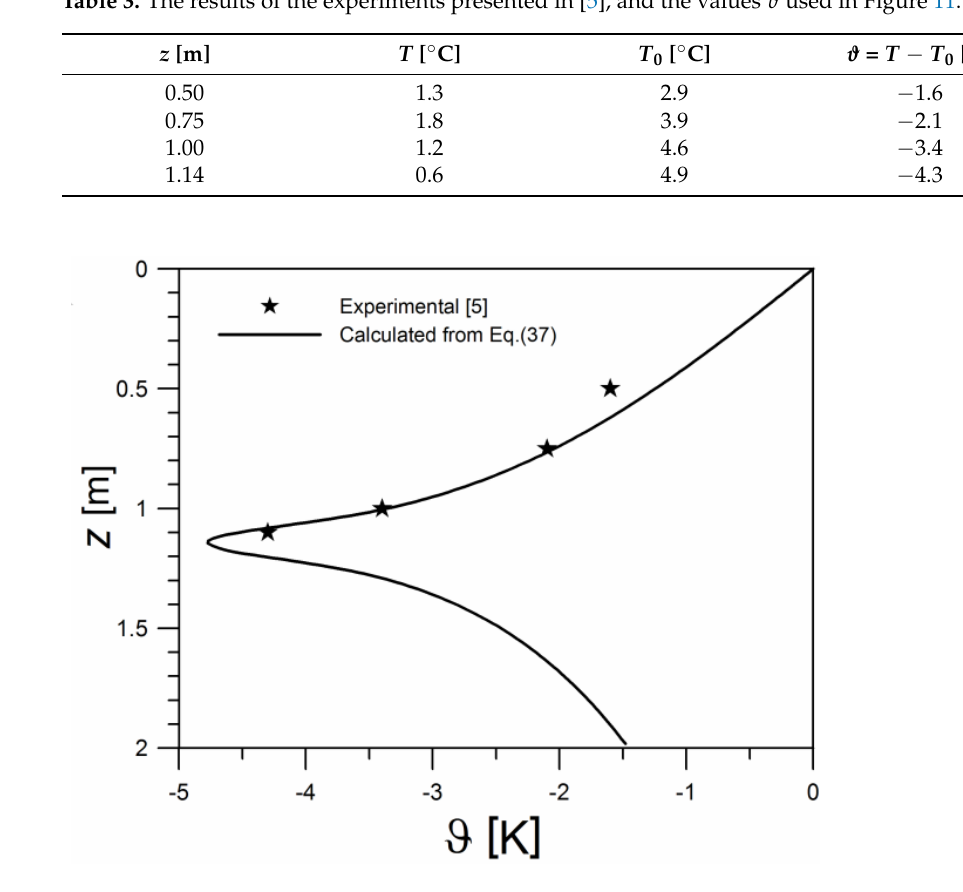
Figure 11. Comparison of experimental and computational results.